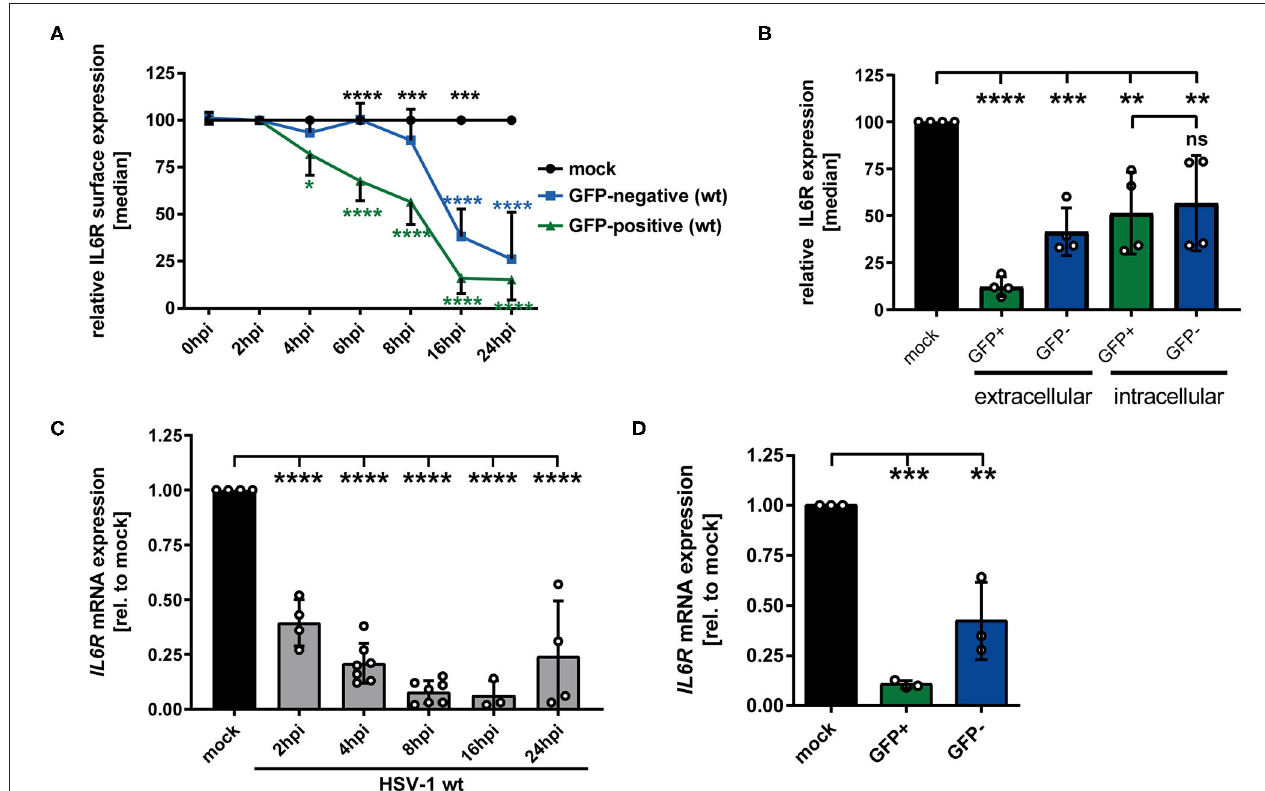
FIGURE 1 | HSV-1 modulation of IL6R expression in/on both GFP-positive directly-infected and GFP-negative bystander mDCs. (A) Mature DCs were mock- or HSV-1 wt-infected (MOI of 0.65) and harvested at indicated time points post infection (0–24 hpi). IL6R surface expression was analyzed on mock (set to 100%, black line), GFP-positive (green line) and GFP-negative (blue line) mDCs by flow cytometry. The experiment was performed at least four times with cells derived from different healthy donors. Green asterisks indicate statistical analyses of GFP-positive vs. mock treated cells, blue asterisks the statistical analyses of GFP-negative vs. mock treated cells and black asterisks the statistics of GFP-negative vs. GFP-positive cells. (B) Mature DCs were mock- or HSV-1 wt-infected (MOI of 0.6) and harvested at 24 hpi. Cells were stained using an IL6R-specific antibody to assess extracellular and intracellular expression levels. IL6R surface expression was analyzed on mock (set to 100%, black line), GFP-positive (green line) and GFP-negative (blue line) mDCs by flow cytometry. Statistical analyses between GFP-positive and GFP-negative samples regarding intracellular IL6R expression levels were carried out applying the unpaired t -test. (A,B) Distinction between infected and uninfected mDCs is based on the GFP signal and the used gates in data evaluation software FCS Express 5, which are specific for either the GFP-positive or GFP-negative population. (C) Mature DCs were mock or HSV-1 wt-infected (MOI of 2, unsorted cells) and harvested at indicated time points post infection (2–24 hpi). RNA was isolated and qPCR was performed. Relative IL6R mRNA expression levels are normalized to S14 and are shown relative to the respective mock condition. The experiment was performed four times with cells isolated from different healthy donors. (D) Mature DCs were mock- or HSV-1 wt-infected (MOI of 0.6) and harvested 16 hpi. Subsequently, cells were sorted based on their GFP expression into GFP-positive and GFP-negative mDCs. RNA was isolated, transcribed into cDNA and used for subsequent qPCR experiments. Relative IL6R mRNA expression levels are normalized to S14. IL6R transcript levels are shown relative to the respective mock condition. The experiment was performed three times with cells derived from different healthy donors. Error bars indicate SD. Significant changes to mock were analyzed using a one-way ANOVA and Bonferroni multiple comparison post hoc tests and are indicated by asterisks (* p ≤ 0.05, ** p ≤ 0.01, *** p ≤ 0.001, **** p ≤ 0.0001). Not significant changes ( p > 0.05) are depicted as